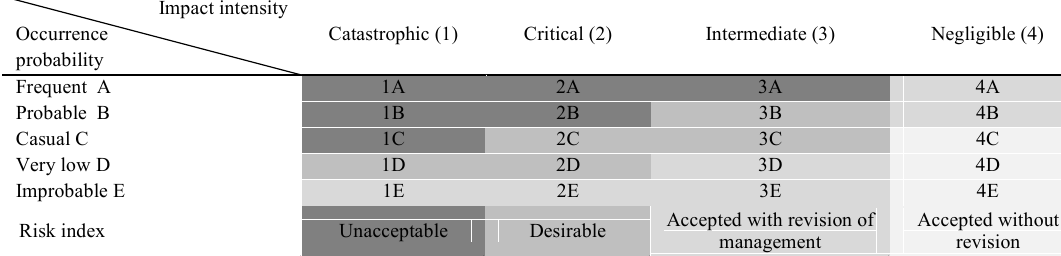
Table 6: Risk assessment by PHA (Rooney et al., 1998)